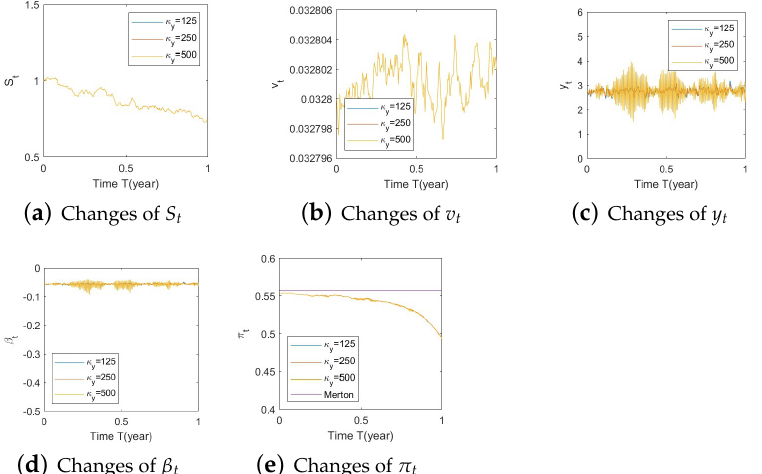
Figure A13. Illustrate the impact on ( a ) stock prices, ( b ) driver of volatility, ( c ) driver of elasticity, ( d ) elasticity of volatility, and ( e ) optimal stock allocations when varying the speed of reversion, κ y ( e . g ., κ y = 125,250,500 ) .